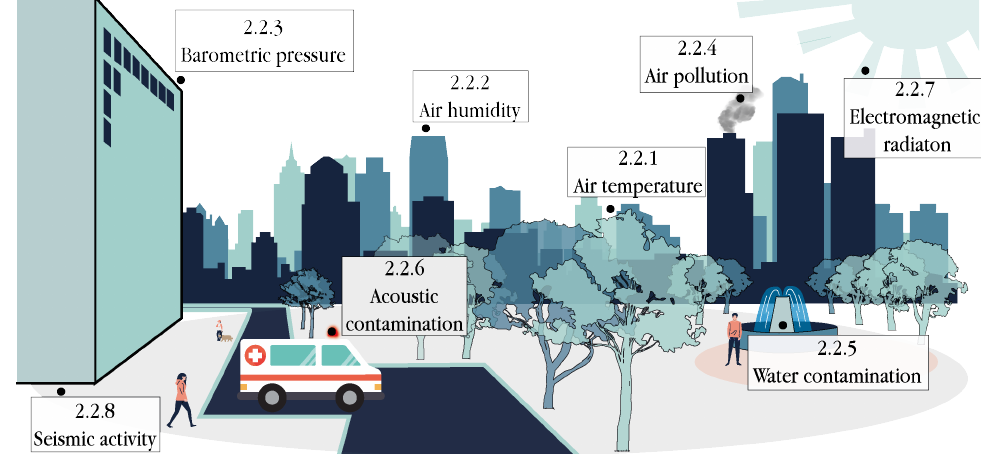
Figure 2. Contextual attributes for smart healthcare that can be sensed from context-aware environments. Table 7. Characteristics of the methods for location sensing and body motion